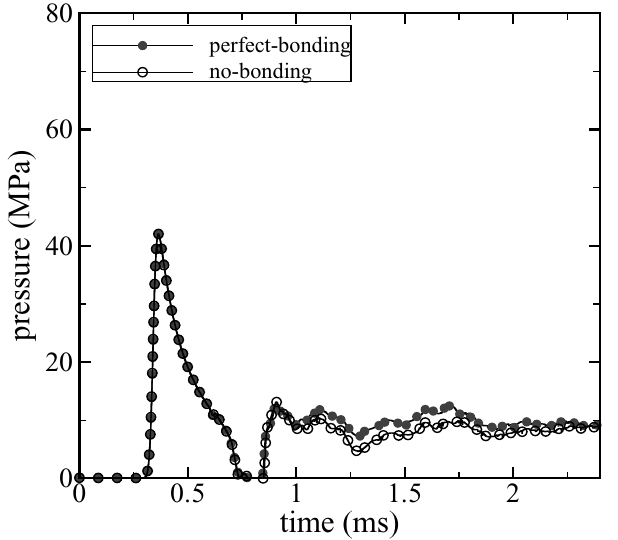
Fig. 5. Comparison of the front face pressure history at quarter-span between the perfect- and no-bonding sandwich plates with clamped ends. perfect- and no-bonding plates. At t = 1 . 5 ms, the wet face pressure for the no-bonding plate is consistently lower than that for the perfect-bonding